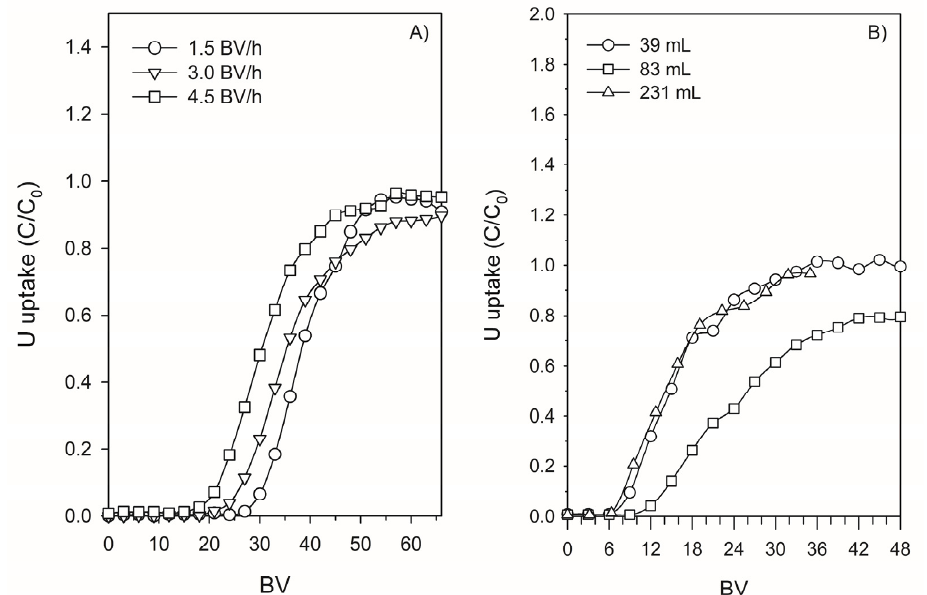
Figure 6. Continuous extraction of uranium on chelating resin Lewatit TP260. Effect of ( A ) flow rate (SCRWL-[KI] int —0.15 M; BV = 12 mL; Flow rate = 1.5 BV/h, 3 BV/h, 4.5 BV/h) and ( B ) geometry (SCRWL-[KI] int —0.15 M; BV = 39 mL, 83 mL, 231 mL; Flow rate = 3 BV/h).